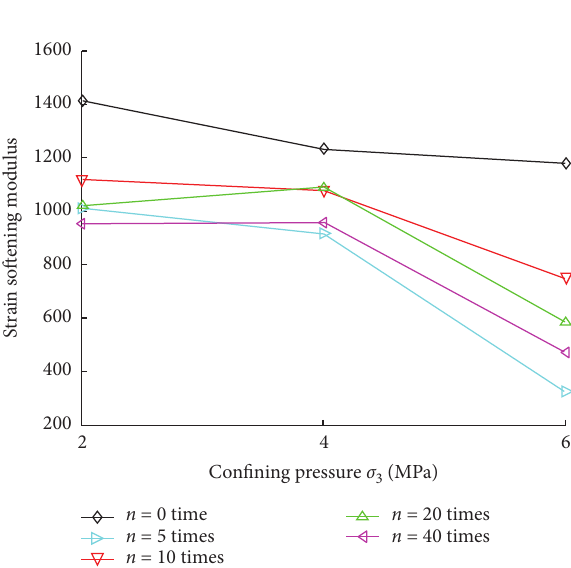
Figure 3: Effect of confining pressure on strain softening modulus.